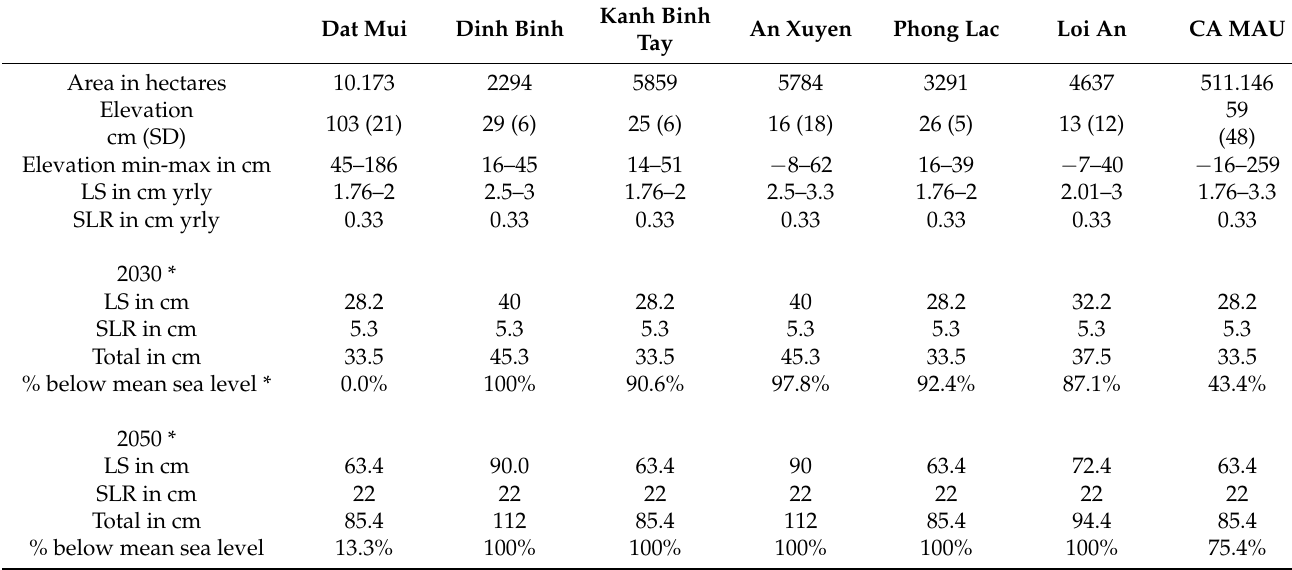
Table 2. Topography and forecasts for SLR and LS in 2030 and 2050, by commune. Kanh Binh An Xuyen Phong Lac Loi An CA Dat Mui Dinh Binh Tay